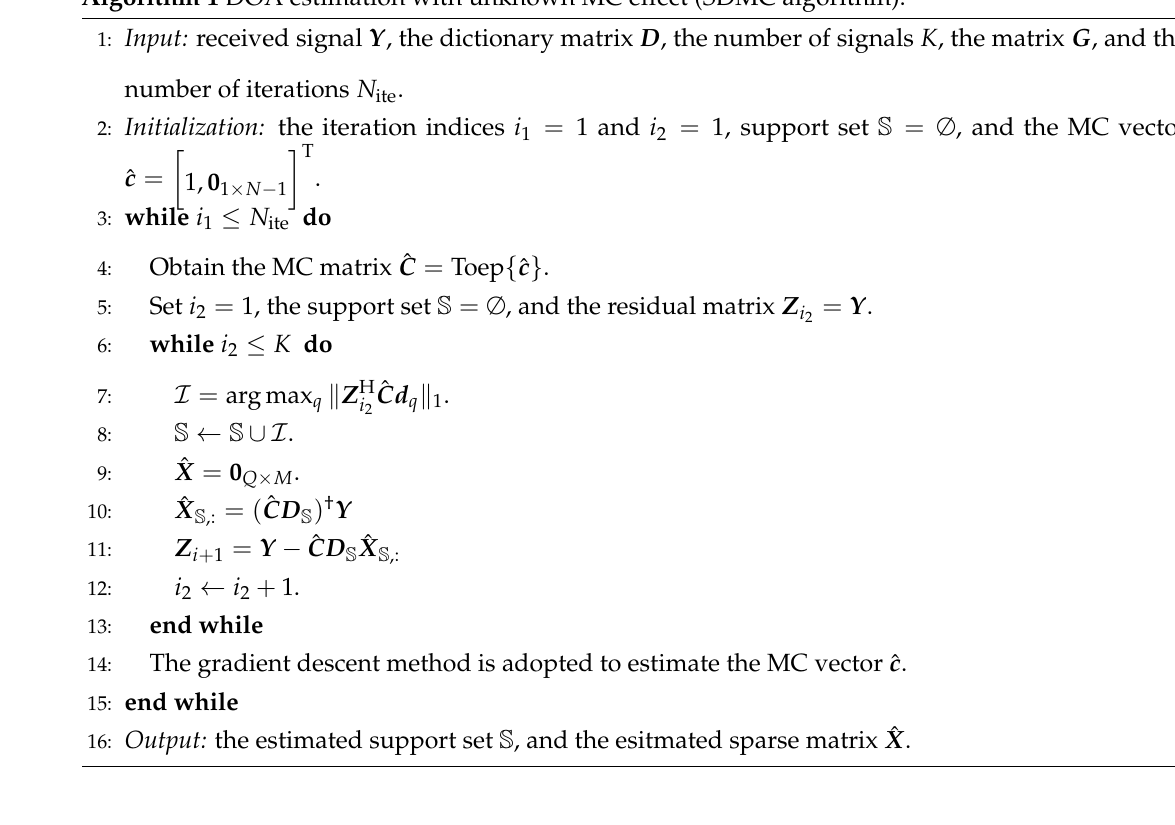
Algorithm 2 MC effect